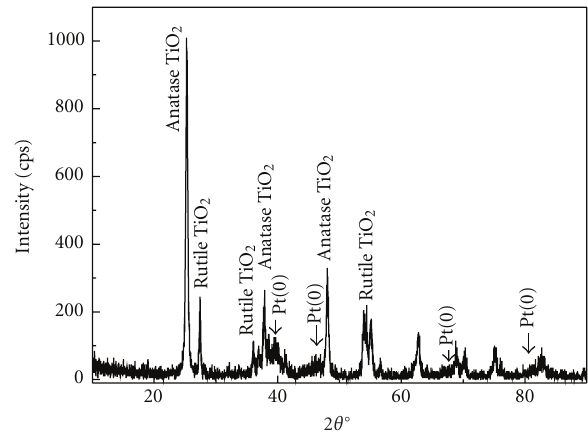
Figure 2: XRD spectra of Pt-TiO 2 .